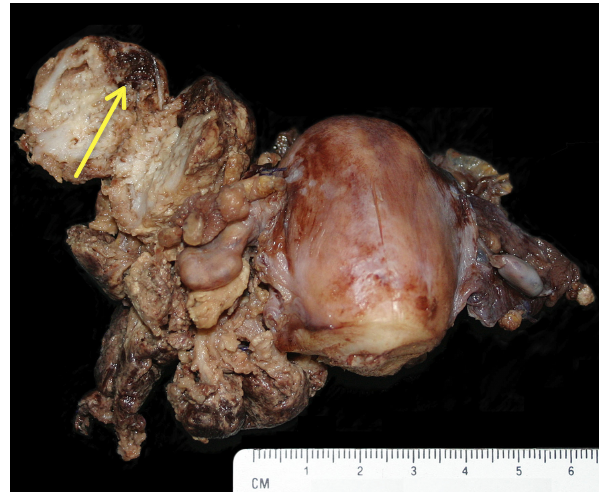
Figure 2. Gross pathology of uterus from rhesus macaque with en- dometriosis. The ovaries and fallopian tubes are embedded and dis- torted by accumulation of solid fibrous masses (scar tissue) and for- mation of endometrial cysts (arrow shows an open large cyst with yellow fibrous nodules in the center and dark red-brown fluid seen at the